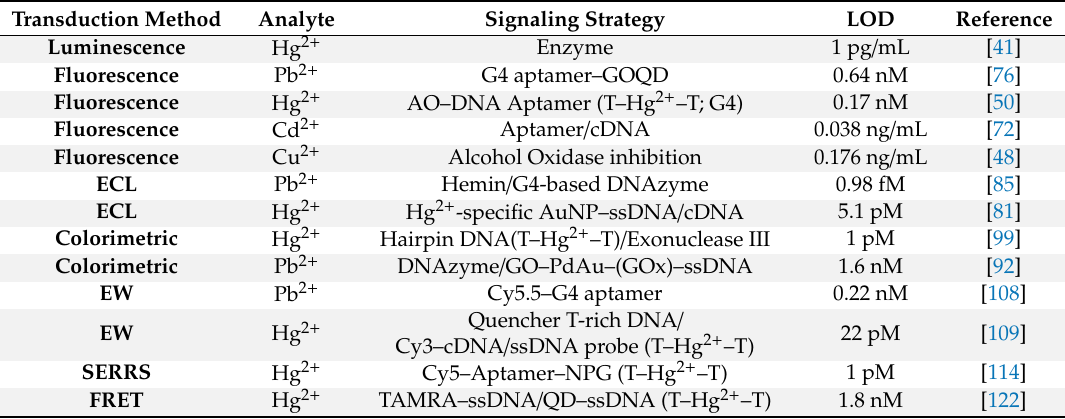
Table 3. Bio-recognition elements giving the lowest detection limits, within the same transduction method, with respect to a specific analyte (n. of published works ≥